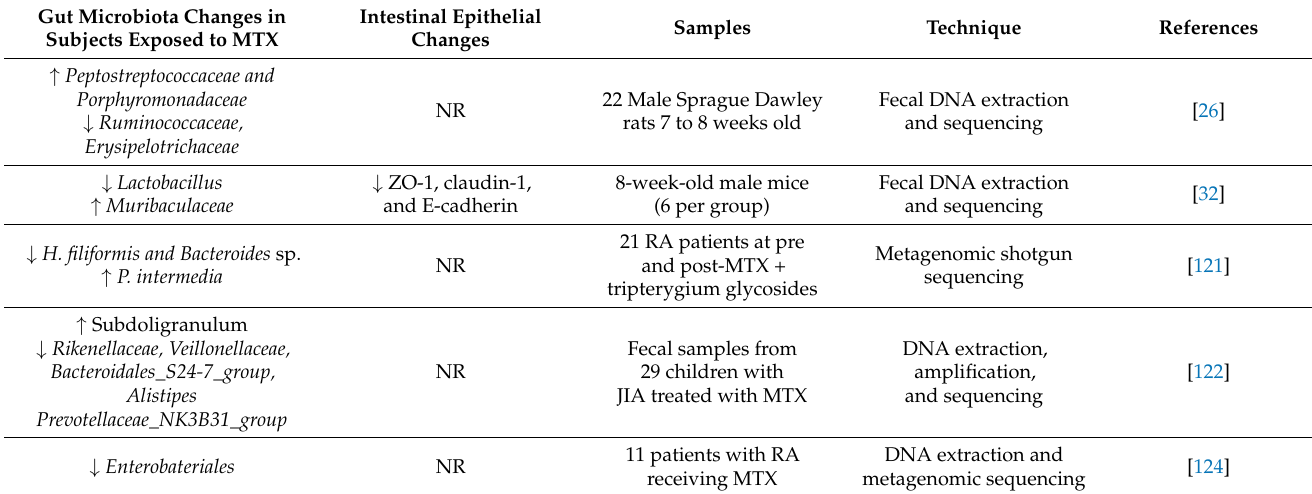
Table 2. Gut microbiota-related changes following treatment with MTX and the associated epithe- lial